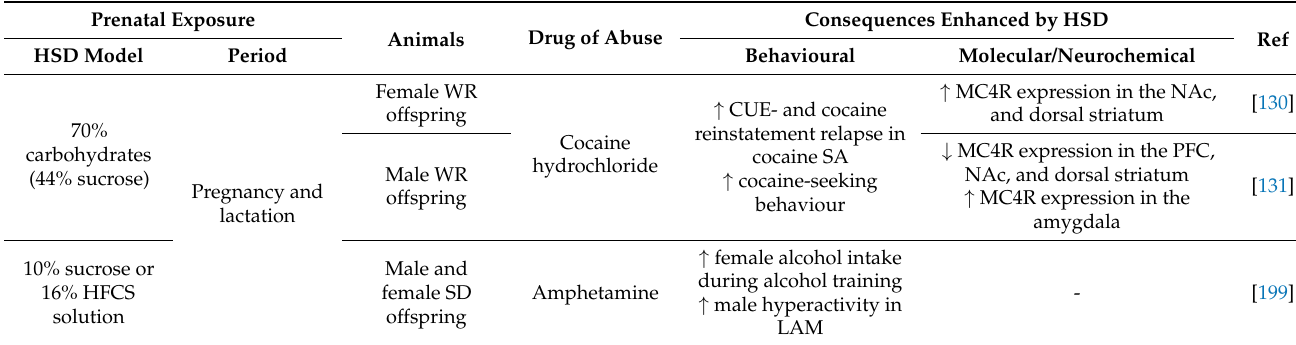
Table 3. Preclinical studies on the prenatal HSD consumption on behavioural and molecular or neurochemical consequences after drugs of abuse in offspring.